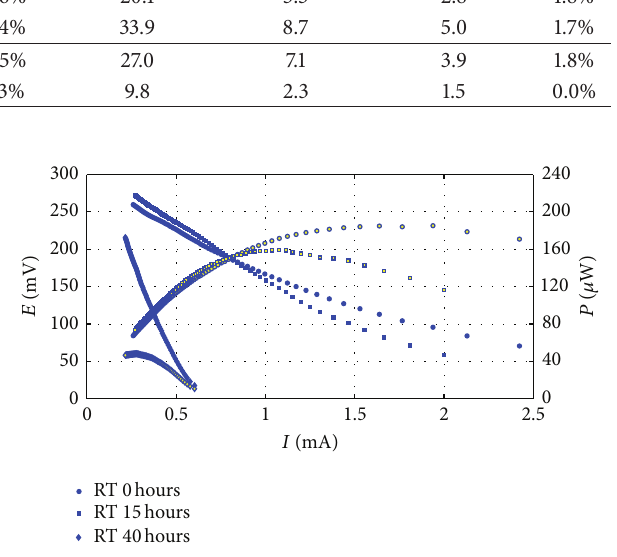
Table 3: MFC feeding with SW1 wastewater. Continuous monitoring results and bioelectrochemical performances calculation. T.C.